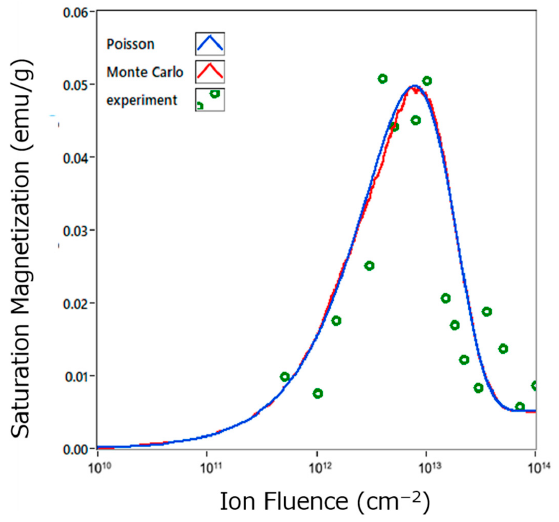
Figure 8. Saturation magnetization of CeO 2 as a function of ion fluence. Green circles, blue line, and red line represent the experimental result [24], result calculated by Equation (13) and the result from two-dimensional images, respectively. The value of S used in Equation (13) is 1.7 × 10 − 13 cm 2 corresponding to the track diameter of 4.7 nm.